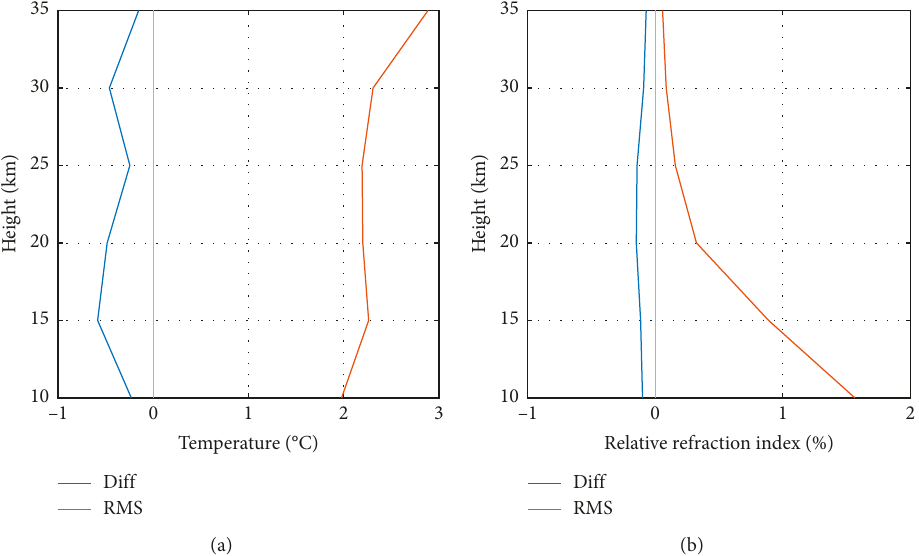
Figure 7: Statistics of temperature profiles and the relative refraction index obtained from FY-3C and COSMIC occultation